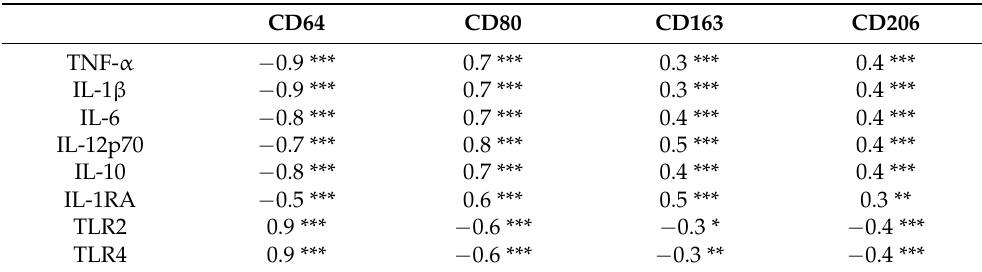
Table 1. Spearman’s correlation matrix of M1 and M2 surface markers, TLR2, TLR4, and secreted cytokines levels. CD64 CD80